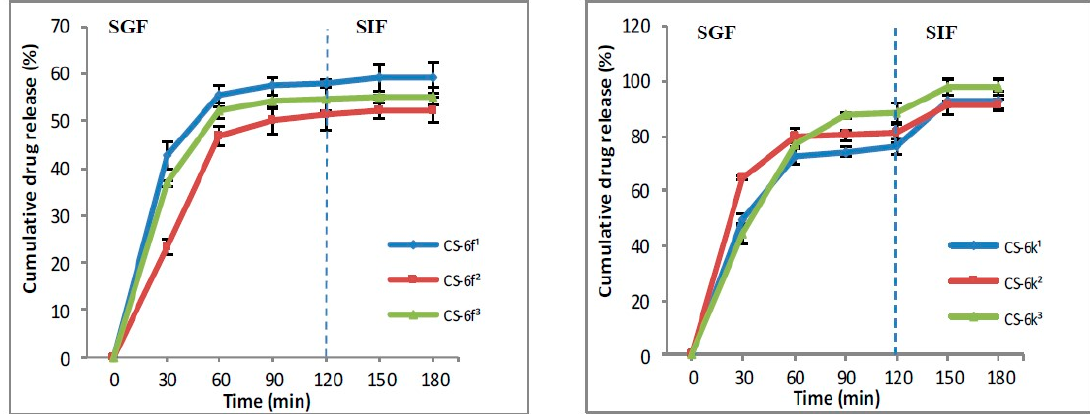
Figure 10. The release profile of compound 6f and 6k from CS-6f and CS-6k respectively ( 1 = 3 mg/mL, 2 = 4 mg/mL, 3 = 5 mg/mL).